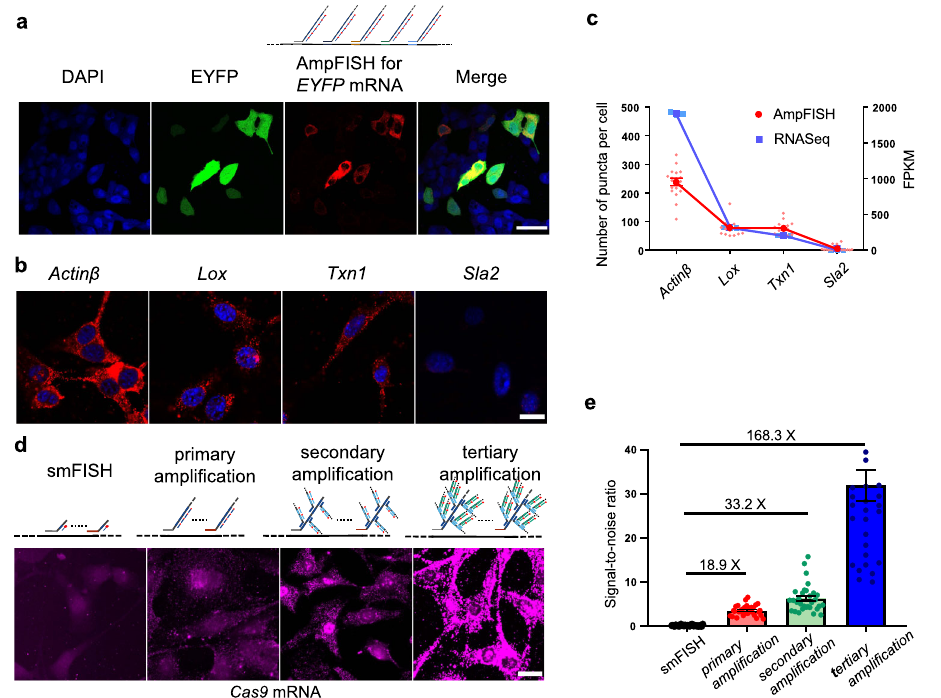
Fig. 2 AmpFISH facilitates labeling of transcripts with high speci fi city and sensitivity (a – c) and the effective ampli fi cation of fl uorescent signals (d – e) in cultured cells. a A set of primary ampli fi cation probes for targeting the EYFP mRNA was used in HeLa cells transiently expressing EYFP. FISH signal (red, signal labeled by Cy5, the third panel from left in ( a ) and fl uorescent protein signal (green signal in EYFP panel, the second panel in ( a ) were imaged in the same fi eld of view (scale bar: 50 μ m). b The four endogenous mRNAs ( Actin β , Lox , Txn1 , and Sla2 ) were assayed using AmpFISH imaging in NIH3T3 cell lines (scale bar: 20 μ m). c The quantitative analysis signal puncta in ( b ) of the four endogenous mRNAs in NIH3T3 cells of AmpFISH puncta per cell are shown. The mean ± SEM of AmpFISH puncta per cell are shown using red round dots, n ( Actin β ) = 20; n ( Lox ) = 15; n ( Txn1 ) = 15, and n ( Sla2 ) = 19. The four transcripts from the RNAseq dataset (blue line and square dots) were compared. Each dot represents the mean ± SEM ( n = 3); FPKM denotes Fragments Per Kilobase Million. These results illustrate the similar relative transcript abundance between the different methods. d Fluorescent signal labeled by TAMRA dye was ampli fi ed by AmpFISH in stable NIH3T3/cas9 cells. The confocal imaging for smFISH (unextended probe), primary, secondary, and tertiary ampli fi cations are arranged from left to right, respectively (scale bar: 50 μ m). e Comparative analysis of the signal-to-noise ratio of different ampli fi cation hierarchies. The intensity of the background signal, from an area adjacent to the area from which the signal was recorded, was subtracted from the intensity of the signal. The signal-to-noise ratio was determined using the formula: (Signal-background)/background.